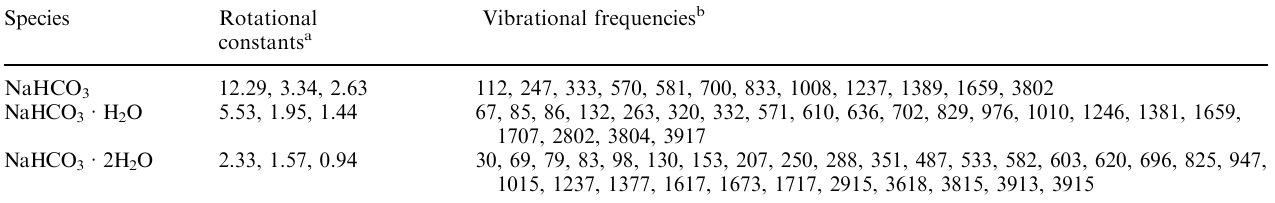
, NaHCO Æ H O and 3 3 2